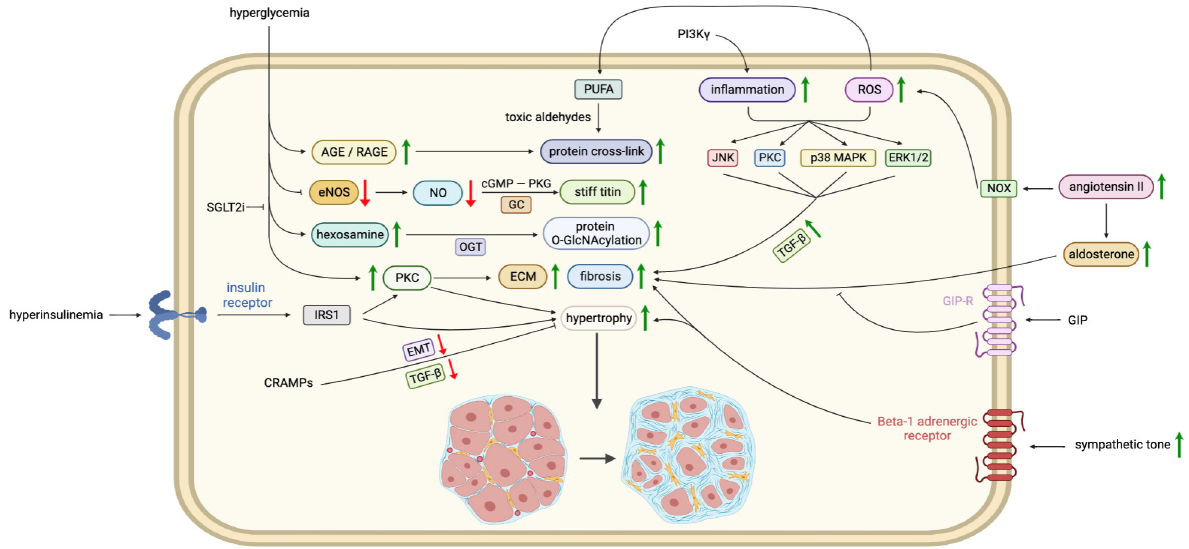
Figure 3. The pathogenesis of extracellular matrix (ECM) accumulation and fibrosis in diabetic car- diomyopathy.PI3K ã :phosphoinositide 3-kinase ã ; ROS: reactive oxygen species; JNK: c-Jun N-terminal kinase, PKC: protein kinase C; p38 MAPK: p38 mitogen-activated protein kinase; GC: guanylate cyclase; cGMP: cyclic guanosine monophosphate; PKG: protein kinase G; ERK1/2: extracellular sig-